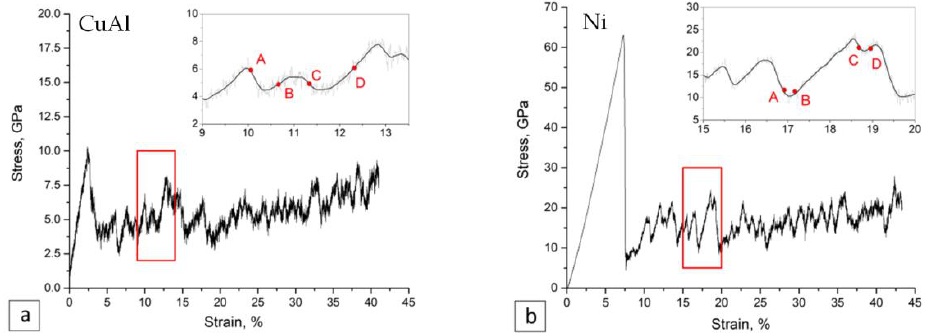
Figure 9. The stress–strain curve of ( a ) CuAl alloy and ( b ) nickel single crystals with a highlighted fragment showing areas of hardening and softening.